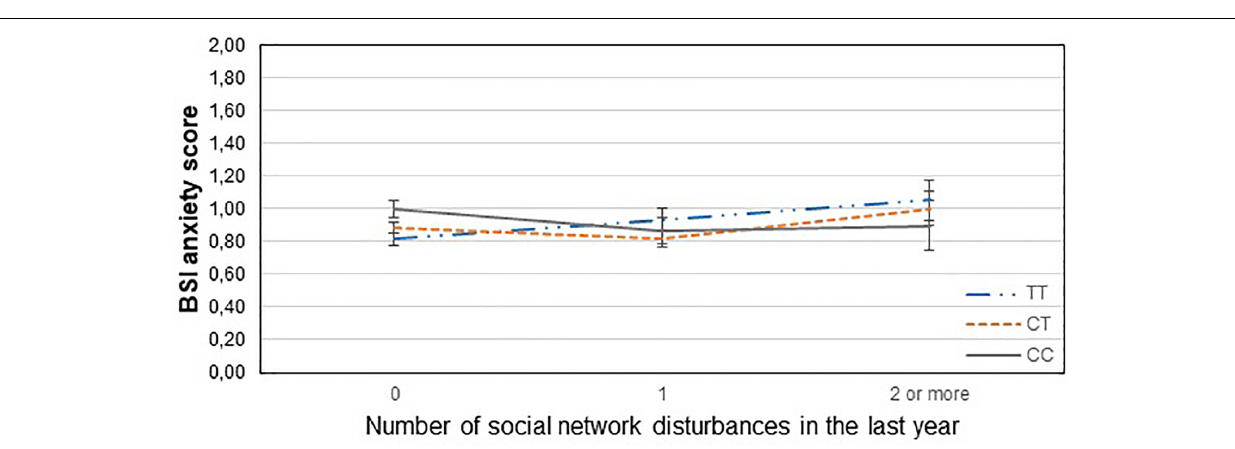
FIGURE 3 | Significant interaction effect of social network disturbances and GABRA6 rs321915 on current anxiety scores in the total sample. Mean BSI anxiety scores are displayed with standard error bars, in function of genotype and the number of life events related to social network disturbances occurred within the last year (general linear model performed only for visualization